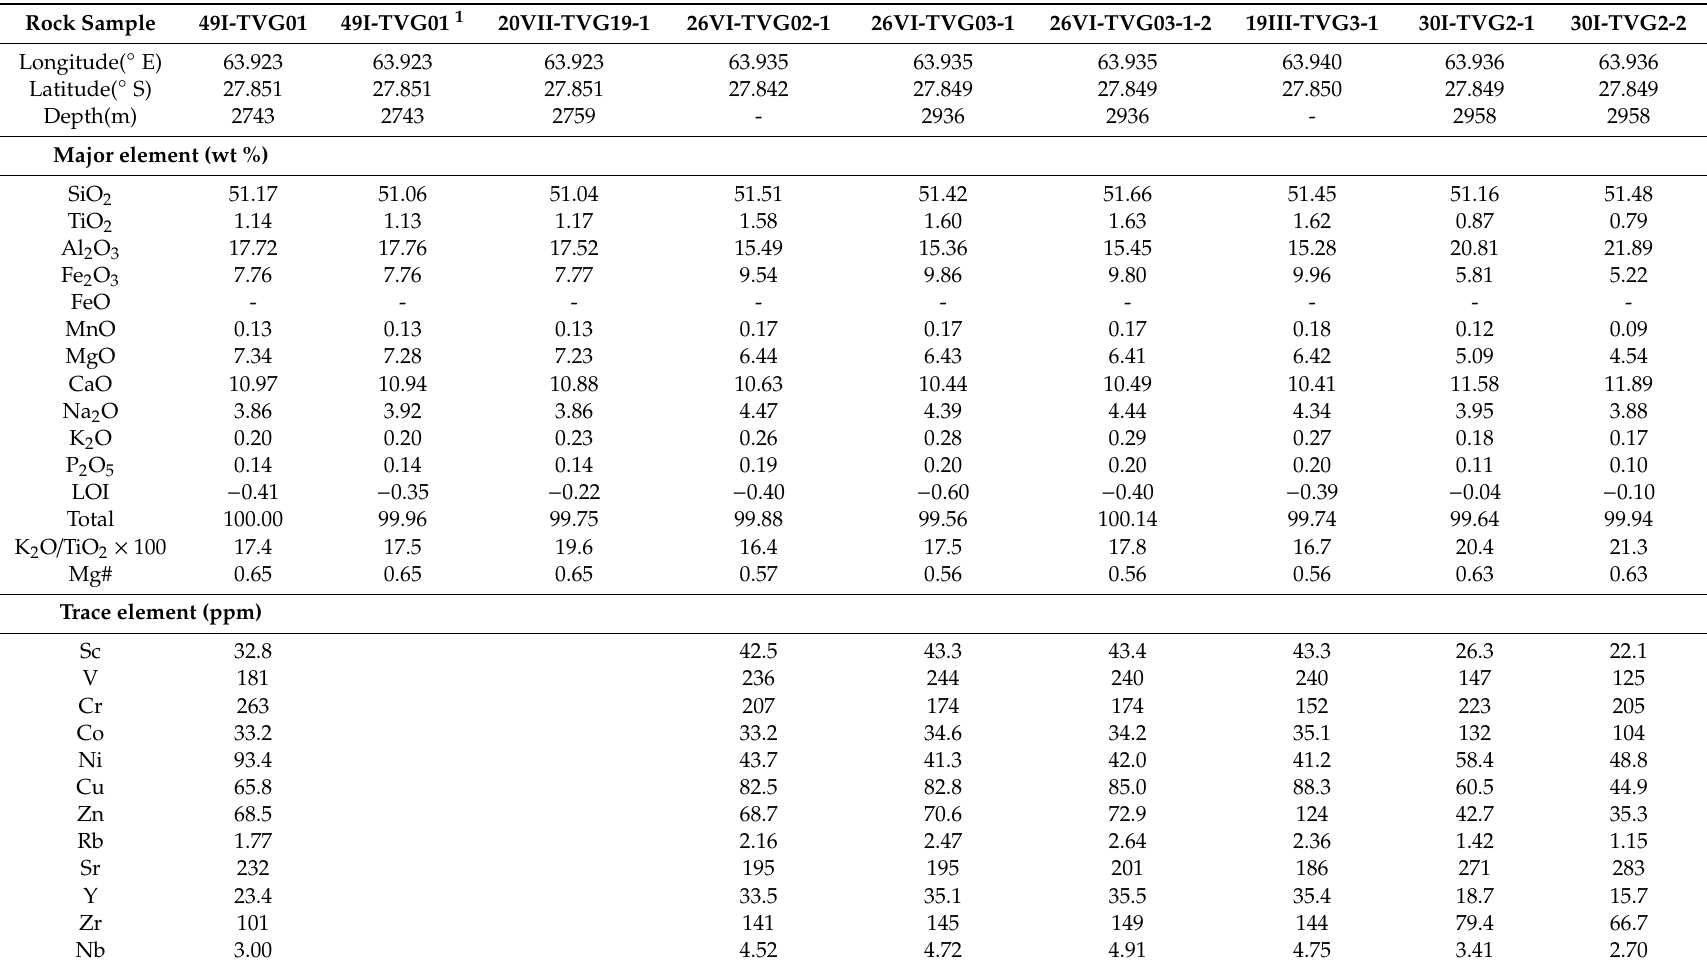
Table 1. Major and trace element compositions of Mount Jourdanne basalts from the Southwest Indian Ridge. Rock